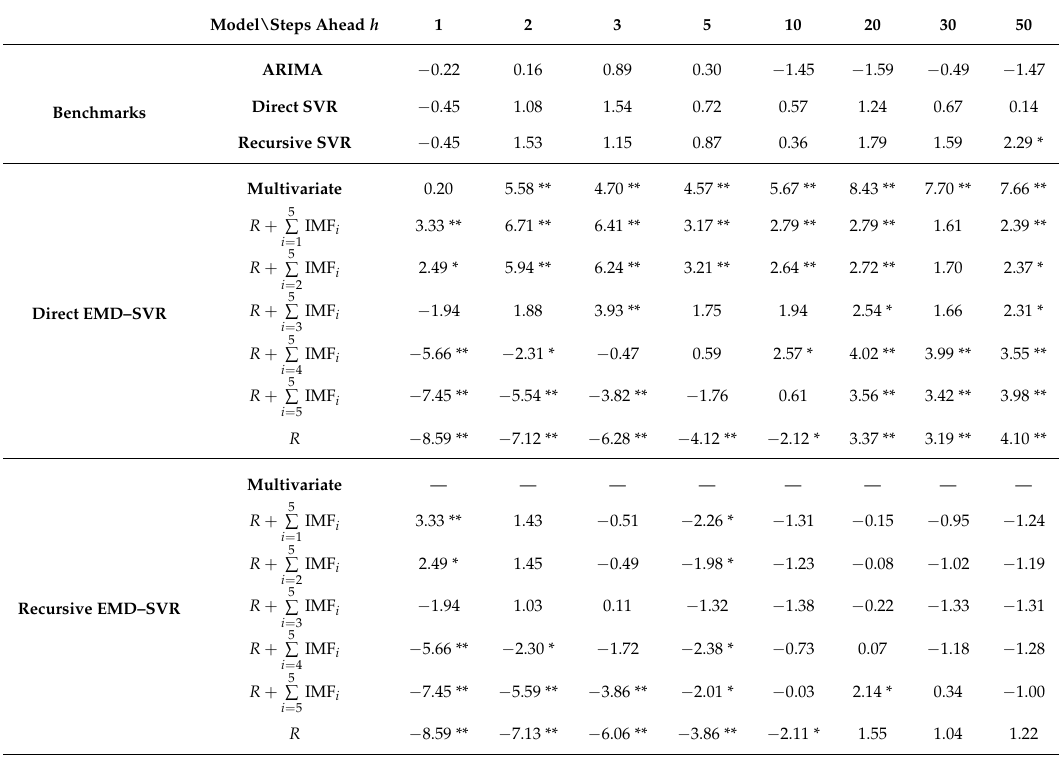
Table A4. Z-statistic for the Wilcoxon signed-rank test for the null hypothesis that the naive model is as accurate as the studied models: autoregressive integrated moving average (ARIMA ( p , d , q ) ), univariate and multivariate empirical mode decomposition–support vector regression (EMD–SVR) with input vector m = 5. Top: direct strategy; bottom: recursive strategy. * Statistically significant at the 5% confidence level. ** Statistically significant at the 1% confidence